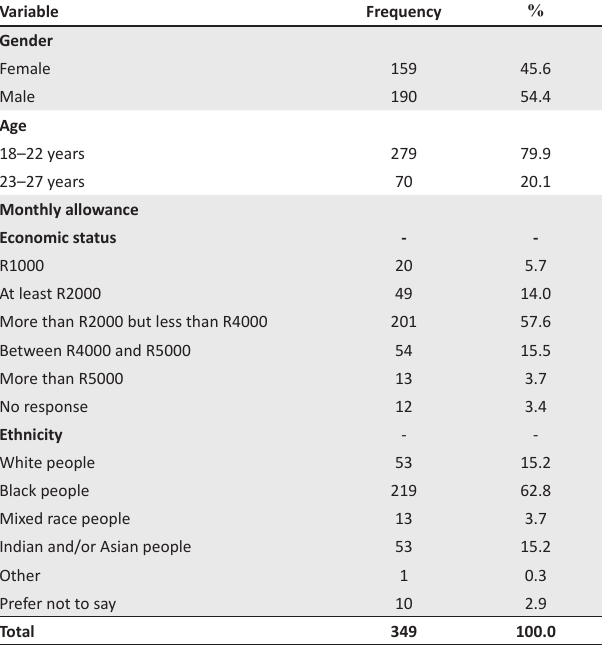
TABLE 1: Sample demographics.